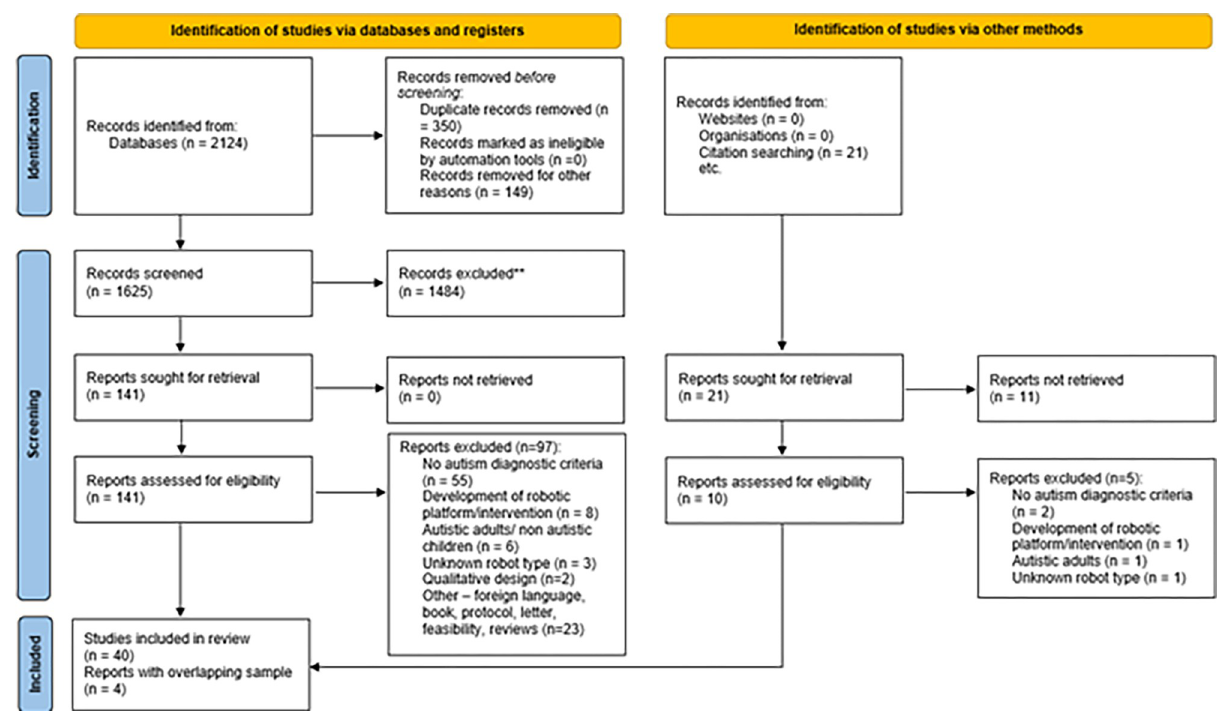
Fig 1. PRISMA flow diagram of the study selection